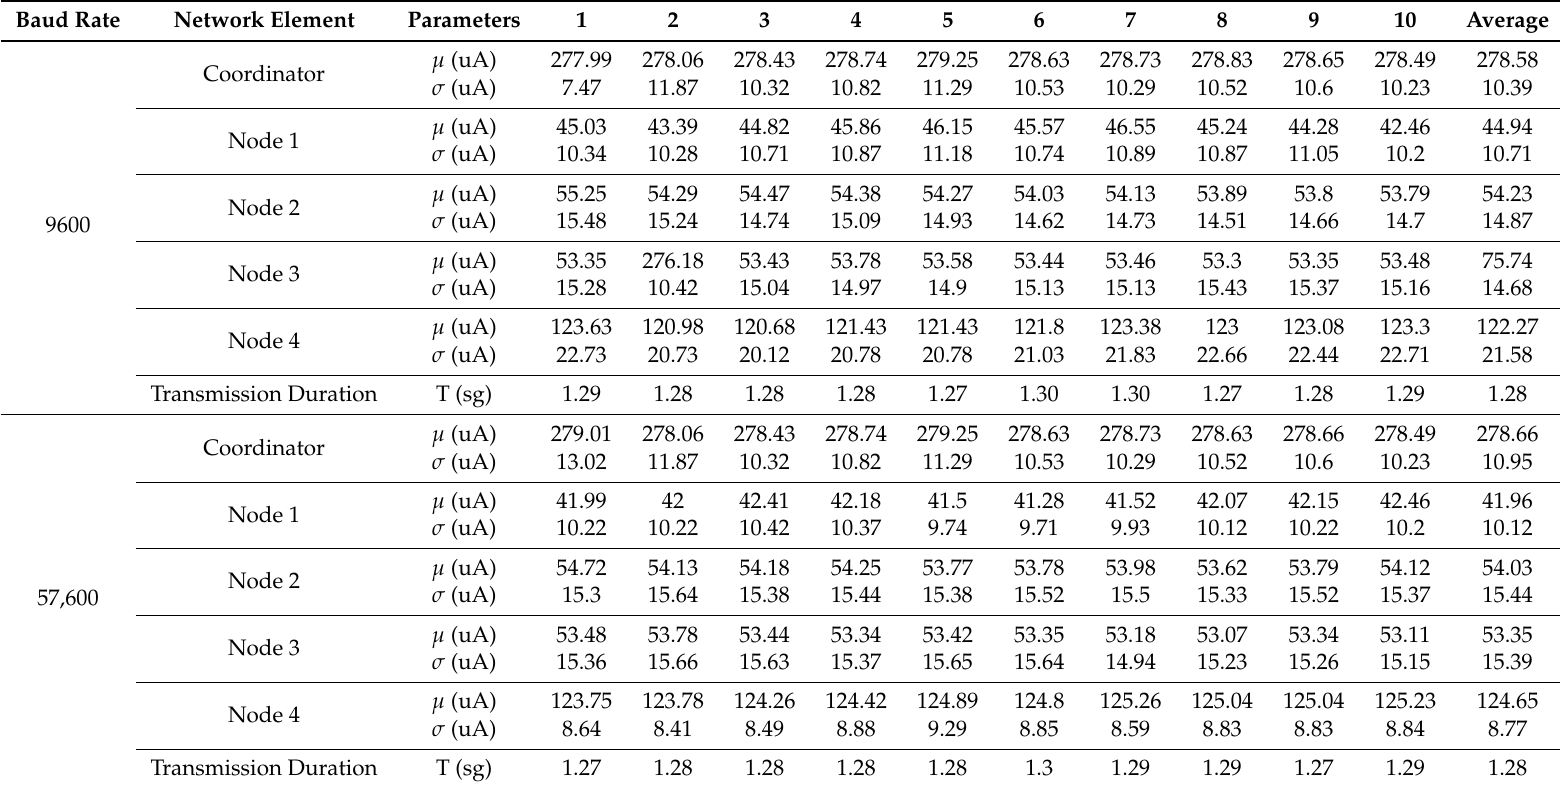
Table 5. Values of energy consumption and transmission duration for the WiFi